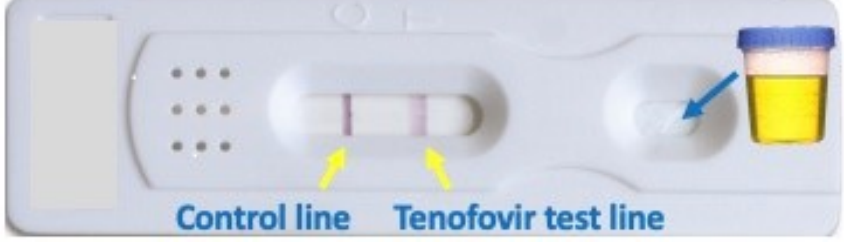
Figure 4. Prototype of point-of-care urine-based tenofovir